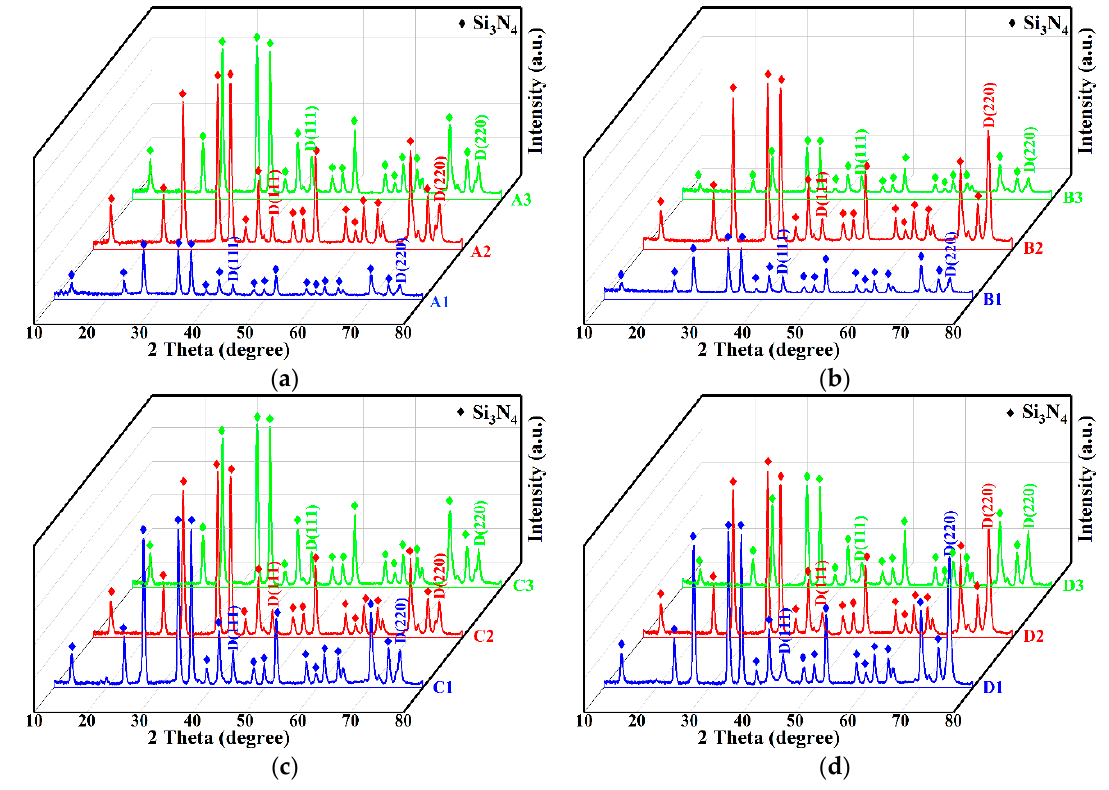
Figure 5. XRD patterns of diamond films with different roughnesses. 1-R a 0.03 μ m, 2-R a 0.1 μ m, 3- R a 0.4 μ m: ( a ) A1–A3 (16 sccm, 8 h, 4.5 mm); ( b ) B1–B3 (16 sccm, 8 h, 3 mm); ( c ) C1–C3 (16 sccm,